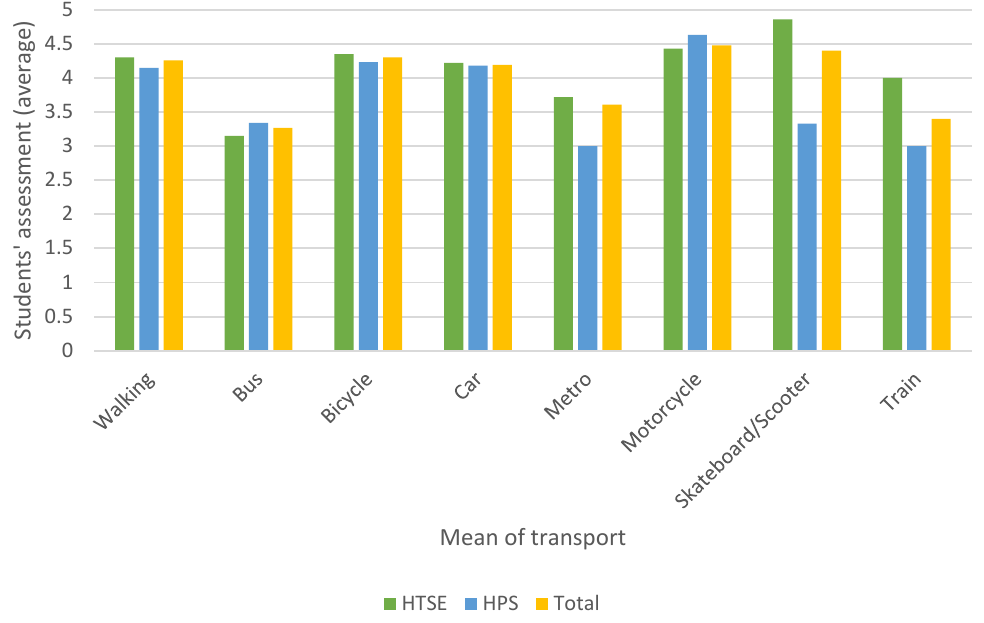
Figure 4. Average of students’ assessment of the most frequently used modes of transportation (Q15).